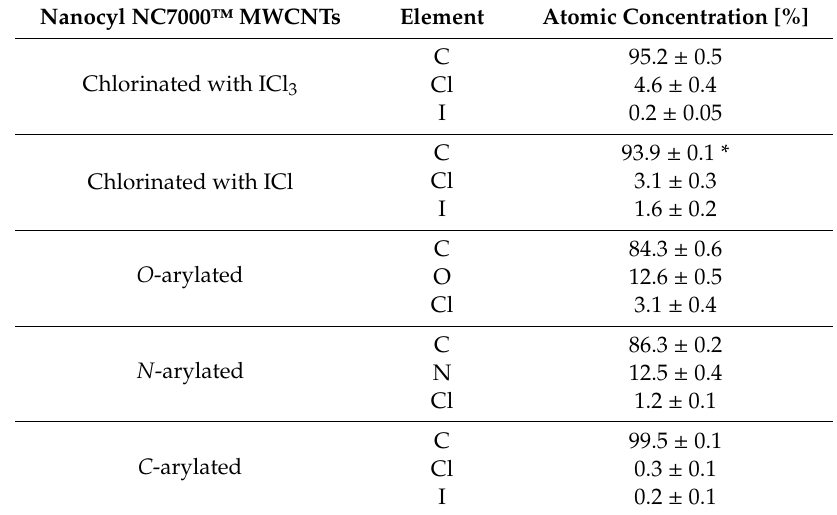
Table 3. EDS chemical composition of representative Nanocyl NC7000 ™ MWCNT